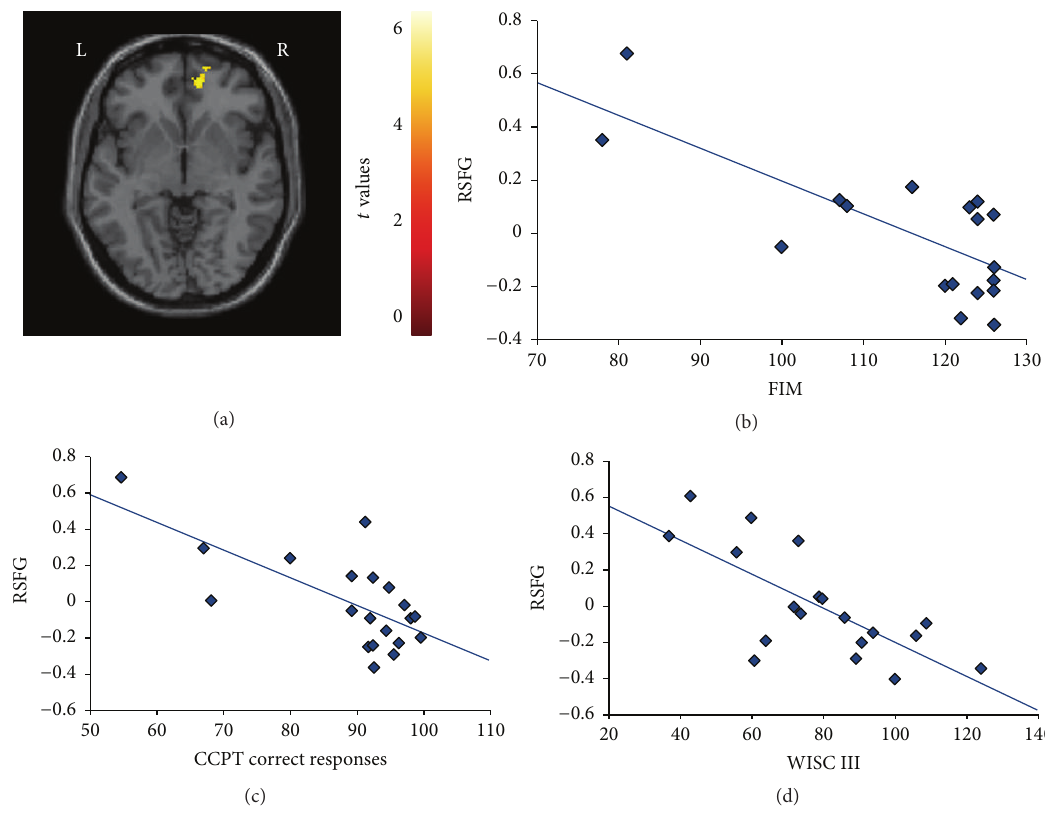
Figure 4: Correlations ( 𝑝 < 0.001 ) between increased functional magnetic resonance imaging activation of the right superior frontal gyrus (SFG) (a) during the load fMRI condition of the Conners Continuous Performance Test (CCPT) in acquired brain injury patients versus (b) Functional Independent Measure (FIM) scores; (c) the percentage of correct responses during CCPT; and (d) Wechsler Intelligence Scale for Children (WISC-III)